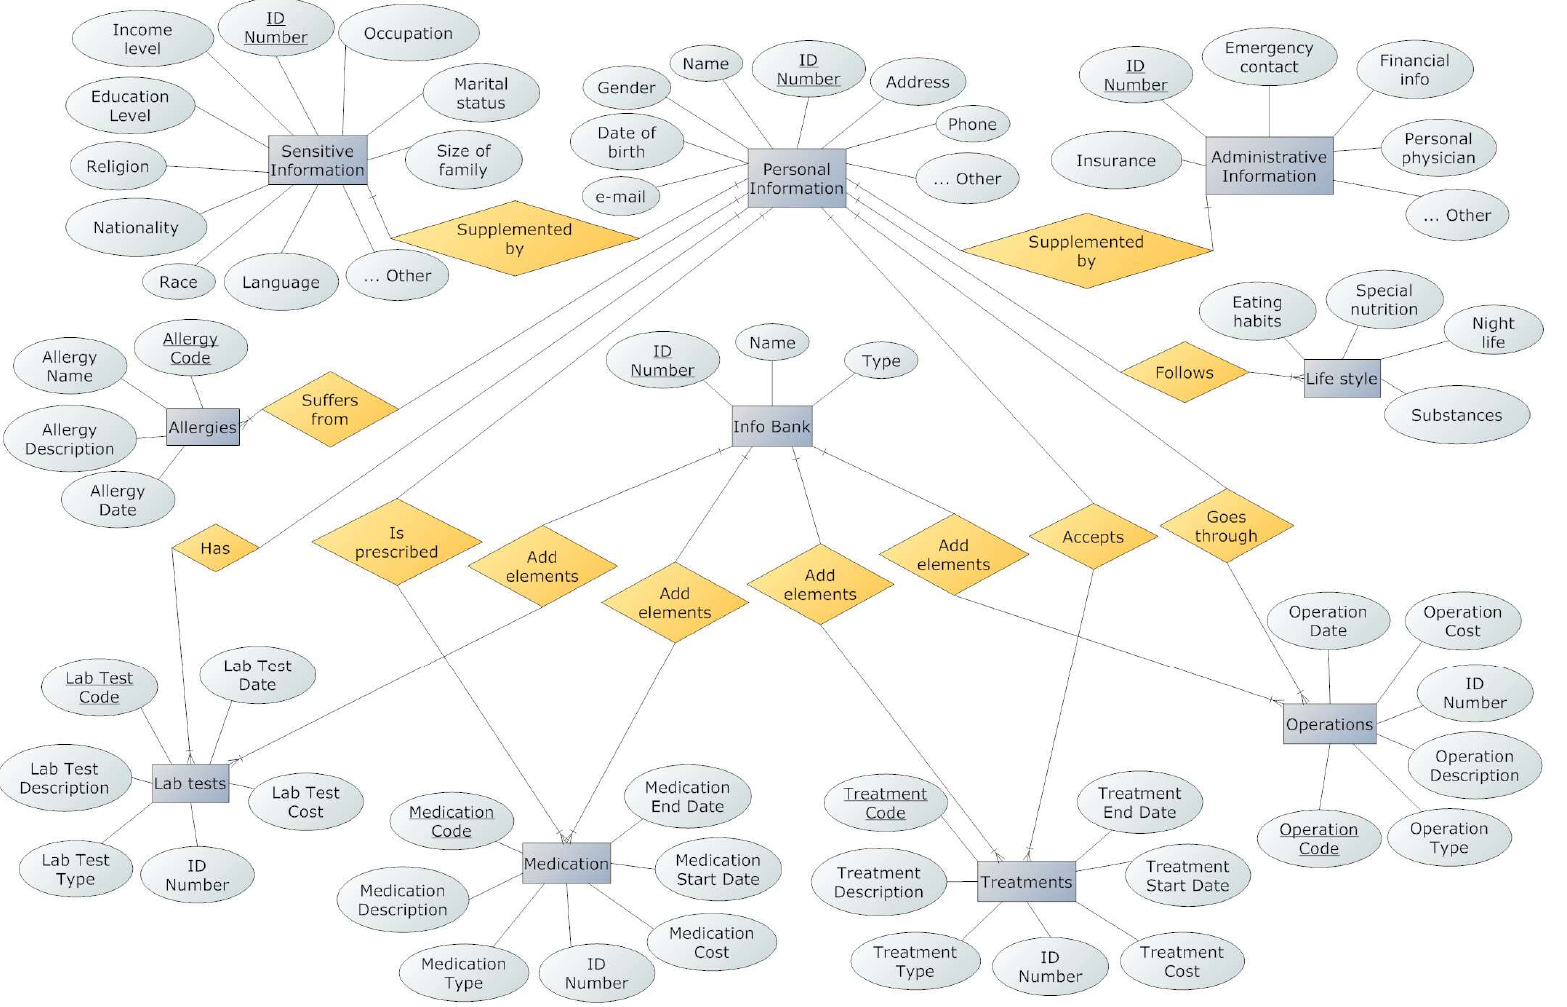
Figure 2. A suggestion of an Entity Relationship Diagram for the EMR system.